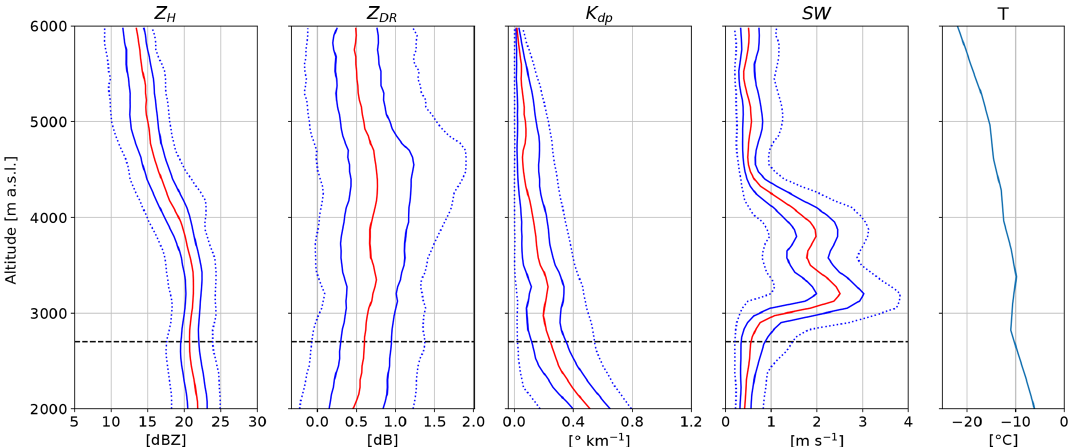
Figure 15. Same as Fig. 7 for 09:00 to 11:00UTC on 28 February 2018. The statistics are based on 20 RHIs towards the MHS site. The dashed black line shows the lower limit of the WCB (black contour in Fig. 5a, b, c).